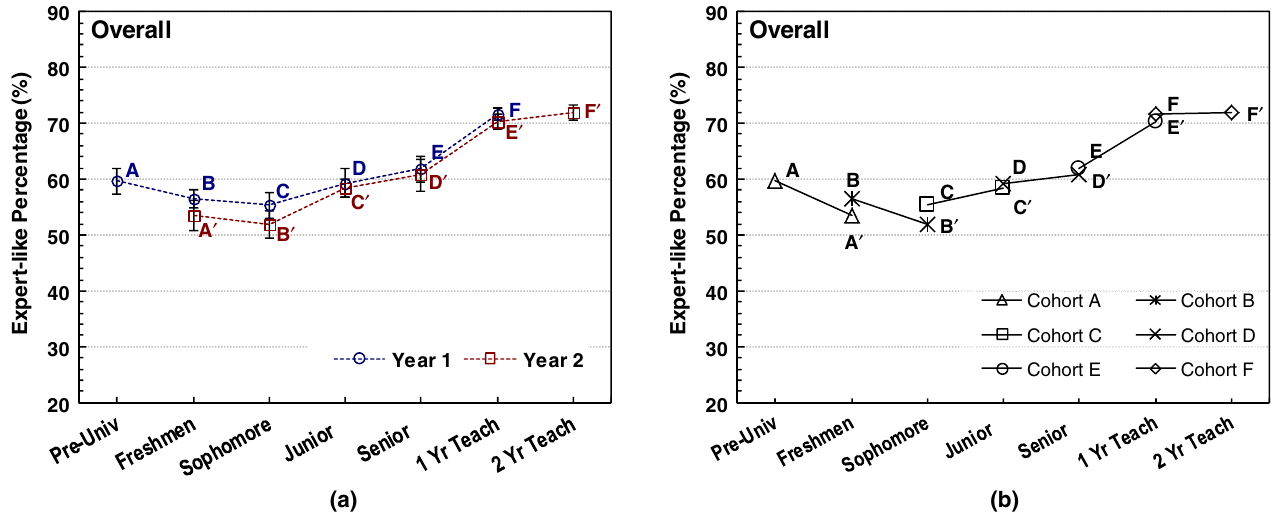
FIG. 2. Pre and post overall CLASS scores for the six cohorts of participants (cohorts A, B, C, D, E, and F). Marks denoted by alphabetical letters without prime signs are pretest results for each cohort; marks denoted by letters with prime signs are post-test results. Error bars represent standard errors. (a) Two cross-sectional trend lines obtained in two consecutive years. (b) Six longitudinal lines for the six